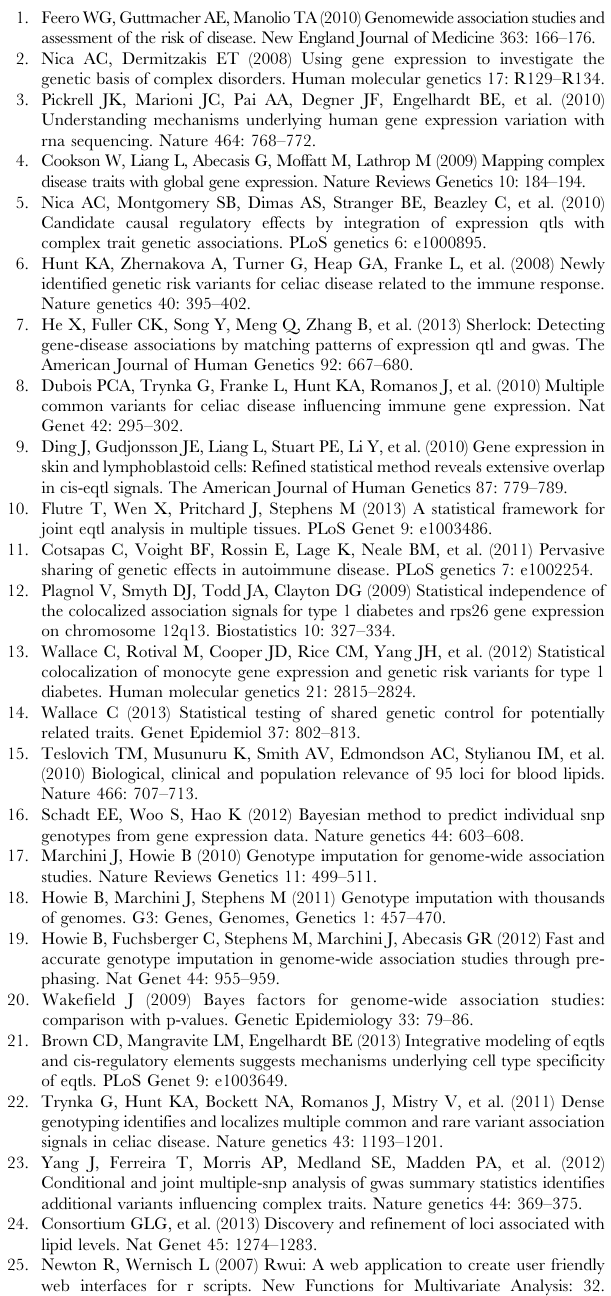
Table S4 eQTL/TG colocalisation. Positive (PP4 . 75%) eQTL/HDL colocalisation results between the liver eQTL dataset and the Teslovich meta-analysis. Column and row headings are the same as in previous figure. Table S5 eQTL/TC colocalisation. Positive (PP4 . 75%) eQTL/HDL colocalisation results between the liver eQTL dataset and the Teslovich meta-analysis. Column and row headings are the same as in previous figure.